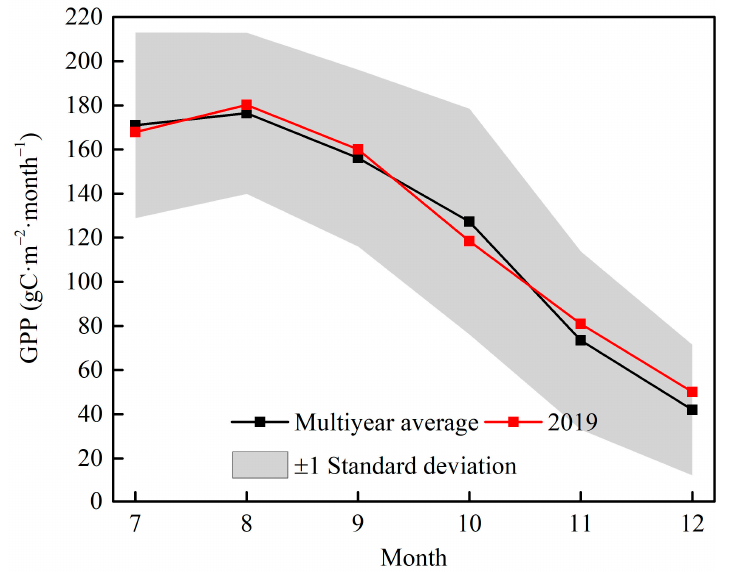
Figure 11. Variation of MODIS GPP from July to December in 2019. Note: The black curve denotes the multi-year monthly average of GPP during 2011–2020; the red curve denotes the monthly aver- age GPP in 2019; the grey shaded areas denote the ±1 standard deviation of the multi-year monthly averages.